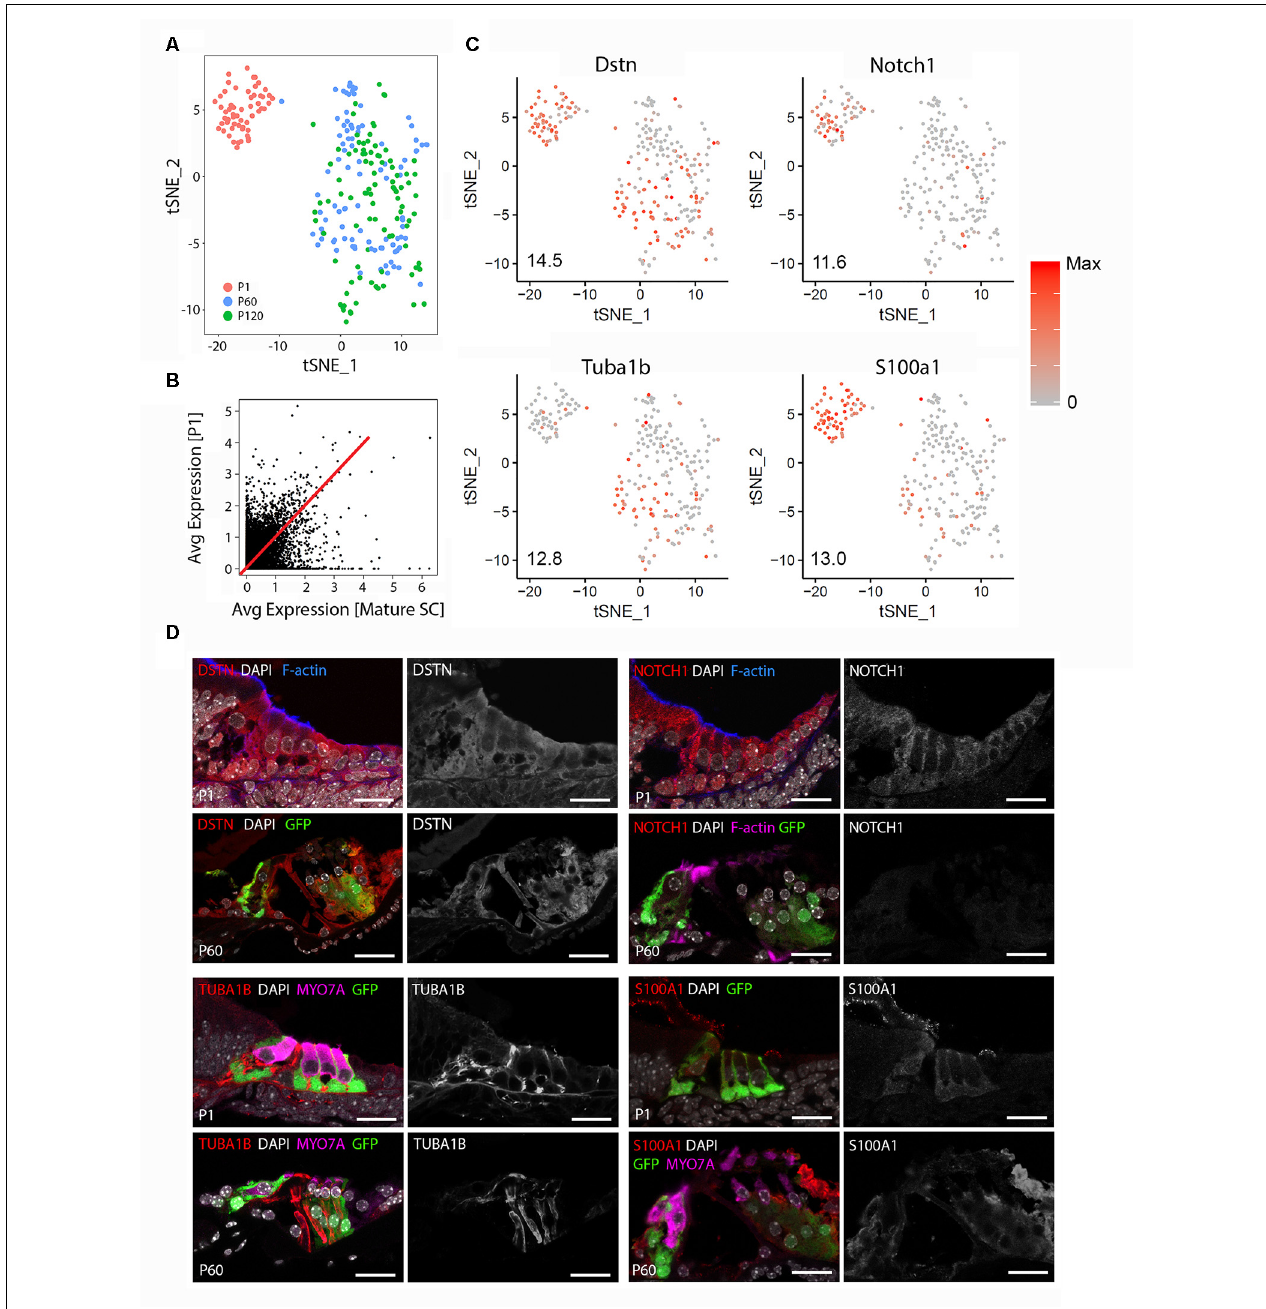
FIGURE 1 | Adult cochlear supporting cells (SCs) are transcriptionally distinct from perinatal cochlear SCs. (A) Unbiased clustering of FACS-purified P1 and mature (P60, P120) cochlear SC transcriptomes demonstrates the clustering of single cells based on the transcriptional expression profiles for each cell. Note that P1 and mature cochlear SCs cluster within their respective groups but exhibit distinct clustering from each other. (B) Comparison of averaged gene expression between FACS-purified mature (P60, P120) and P1 cochlear SCs indicates both equivalent (genes expressed on or near the red line) and differential (genes located closer to either axis) expression between the two cell stages. (C) Feature plots of select known cochlear SC genes ( Dstn, Notch1, S100a1, Tuba1b ) demonstrate distinct differences between P1 and mature cochlear SCs. An expression is shown in log2 [nTPM] with the maximum expression value (Max) shown in the lower-left corner of each plot. The expression histogram is shown with red indicating higher expression. (D) Representative immunohistochemistry validating transcriptional differences between P1 and mature cochlear SCs in the organ of Corti from Lfng EGFP mice. Each 4-panel grouping demonstrates P1 and P60 immunohistochemistry with the protein of interest in the red channel (left panels) at P1 (upper left panel) and P60 (lower left panel) and the gray scale single-channel images of the protein of interest (right panels) at P1 (upper right panel) and P60 (lower right panel). Known protein expression (DSTN, NOTCH1, S100A1, TUBA1B) is demonstrated (Upper left Four panels and proceeding clockwise). Staining for F-actin or MYO7A identifies hair cell (HC) stereocilia or HCs, respectively. Scale bar, 20 µ m.